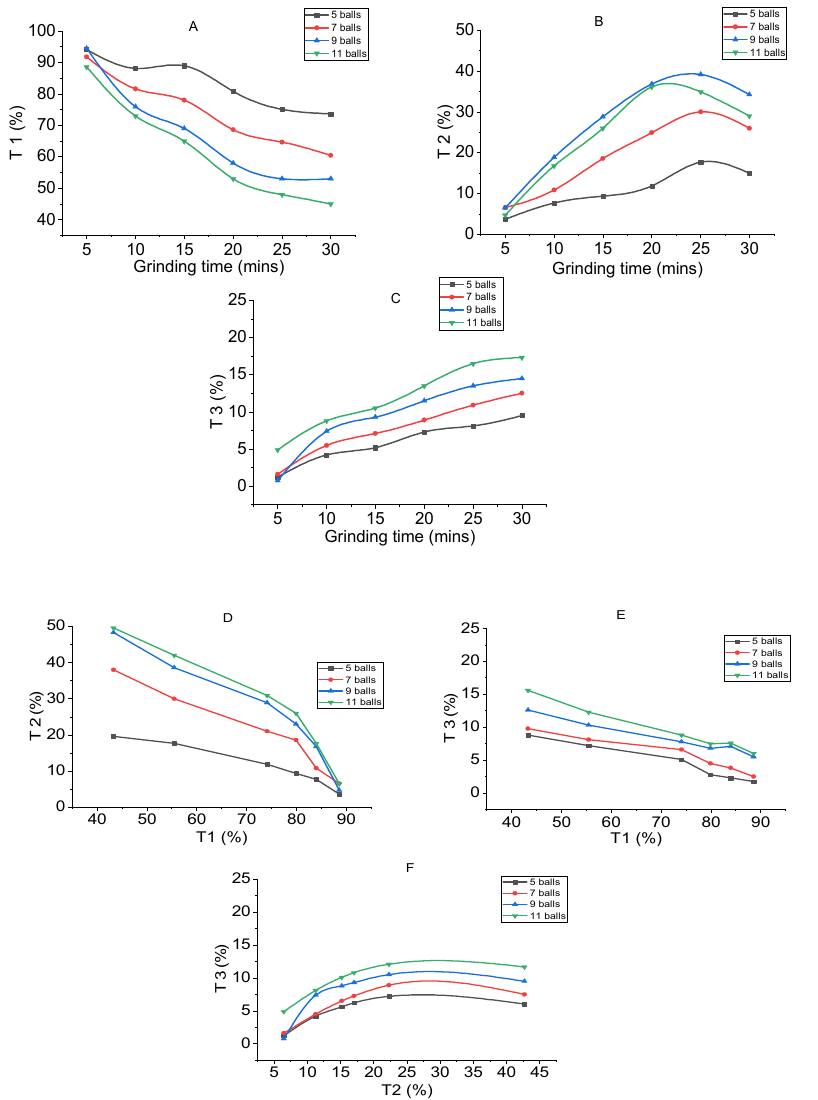
Figure 4. ( A – C ) plots of T1, T2 and T3 vs. grinding time, respectively (bed mass = 250 g, varied no. of balls, shaking time 20 min). ( D – F ) plots of T2 vs. T1, T3 vs. T1 andT3 vs. T2, respectively (mass fraction of middle size class against the mass fraction of the feed of the sample for different times).